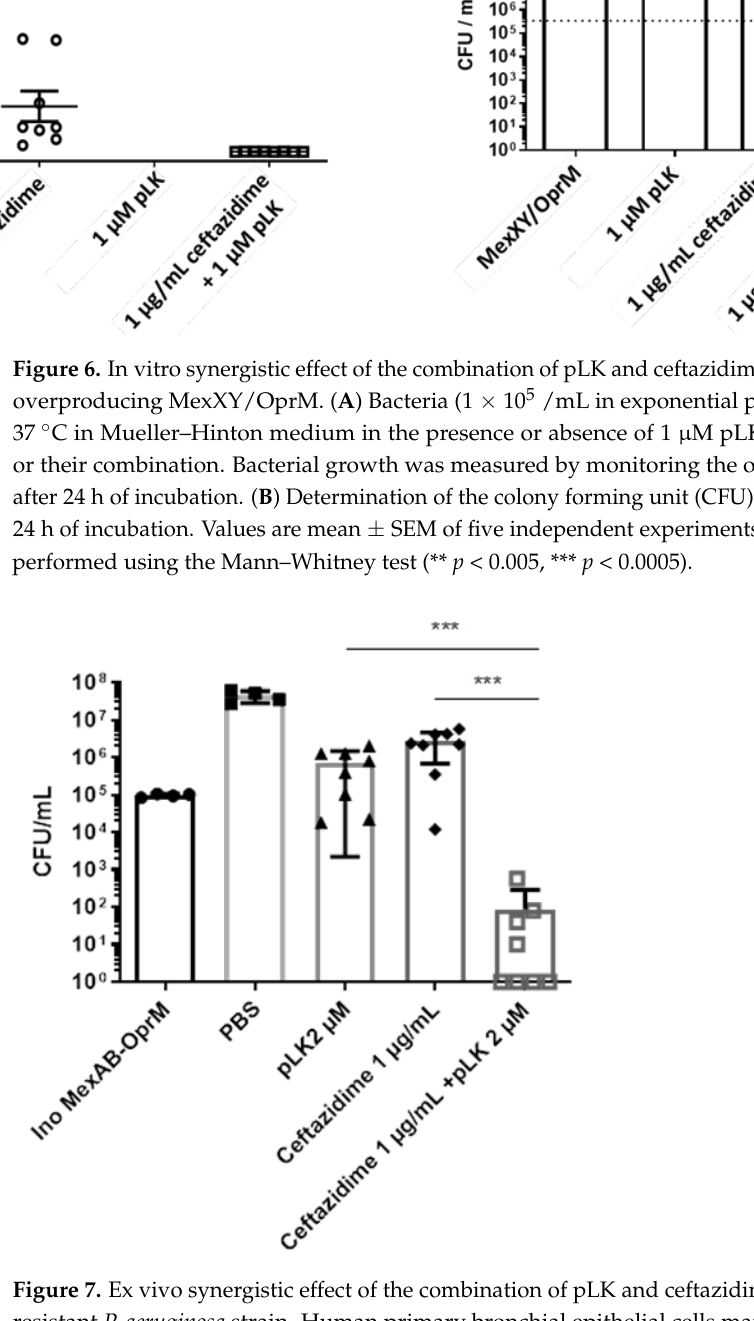
Figure 6. In vitro synergistic effect of the combination of pLK and ceftazidime on a P. aeruginosa strain overproducing MexXY/OprM. ( A ) Bacteria (1 × 10 5 /mL in exponential phase) were incubated at 37 °C in Mueller – Hinton medium in the presence or absence of 1 µM pLK, 1 µg/mL ceftazidime, or their combination. Bacterial growth was measured by monitoring the optical density at 600 nm after 24 h of incubation. ( B ) Determination of the colony forming unit (CFU)/mL was evaluated after 24 h of incubation. Values are mean ± SEM of five independent experiments. Statistical analysis was performed using the Mann – Whitney test (** p < 0.005, *** p < 0.0005).